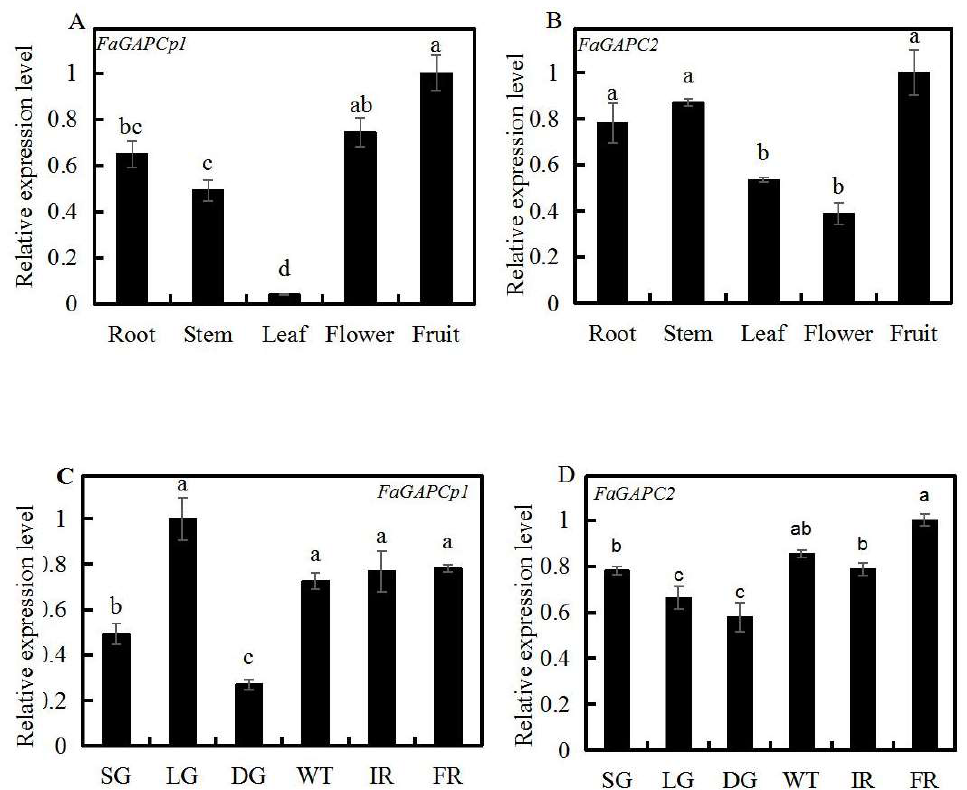
Figure 3. Transcript levels of FaGAPC2 and FaGAPCp1 in di ff erent tissues / organs and developmental stages. ( A ) FaGAPCp1 transcript levels in root, stem, leaf, flower, and fruit; ( B ) FaGAPC2 transcription levels in root, stem, leaf, flower, and fruit; ( C ) FaGAPCp1 transcript levels in di ff erent developmental stages; ( D ) FaGAPC2 transcript levels in di ff erent developmental stages. Small green (SG, 7 d after anthesis), large green (LG, 14 d after anthesis), de-greening (DG, 18 d after anthesis), white (WT, 20 d after anthesis), initial red (IR, 23 d after anthesis), and full red (FR, 28 d after anthesis). Values are means ± SD of three biological replicates. An overall significant di ff erence ( p ≤ 0.5) is represented by di ff erent lower-case letters as determined by Duncan’s multiple range test; a, b and ab show the significance of di ff erences between groups of